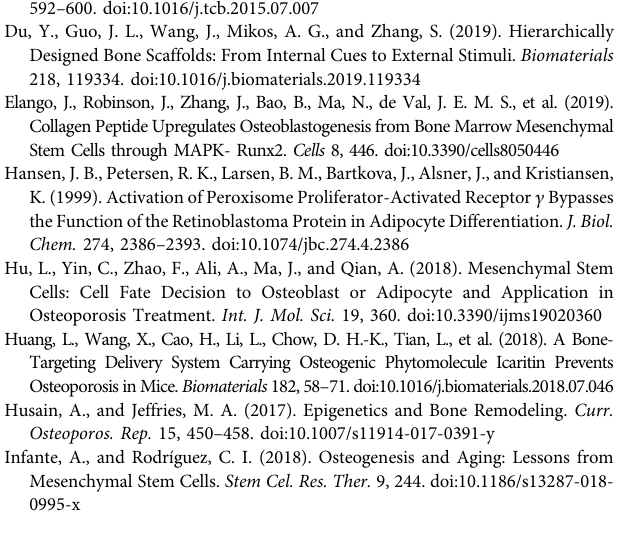
Frontiers in Cell and Developmental Biology |